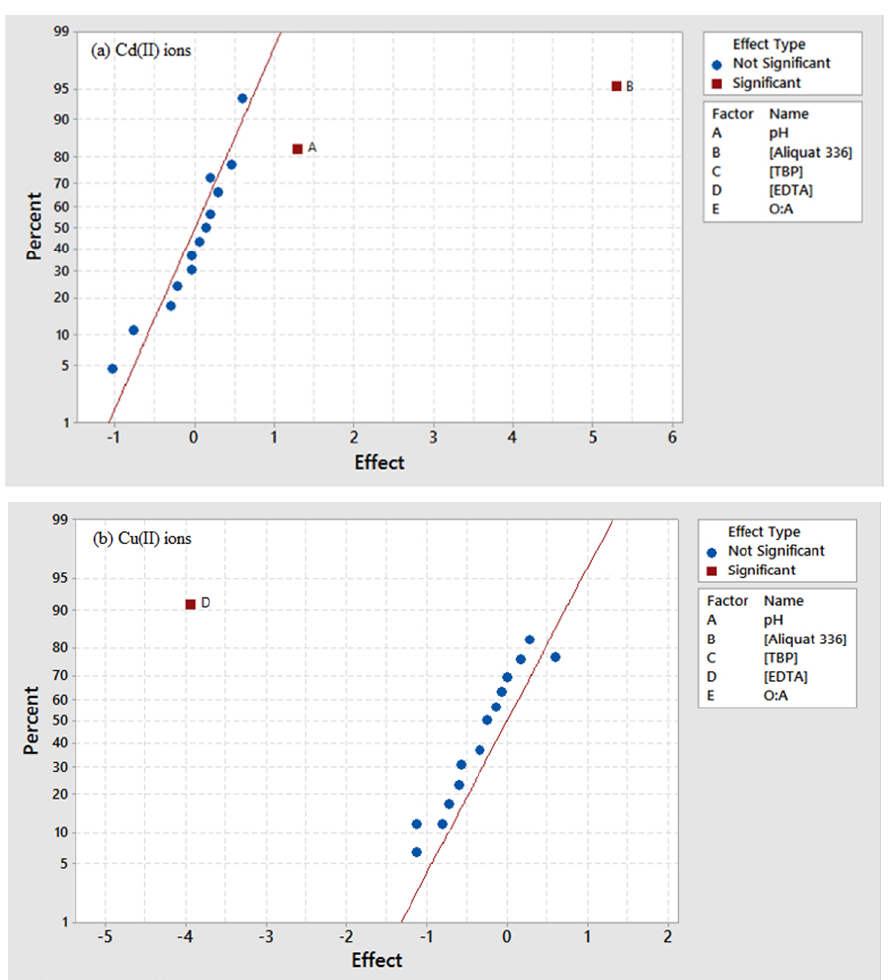
Figure 4. Normal probability plots for ( a ) extraction of Cd(II) ions and ( b ) extraction of Cu(II) ions.